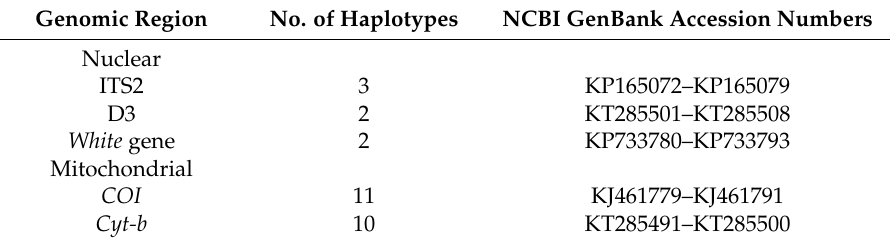
Table 7. Number of haplotypes of each genomic region and the accession numbers received from the NCBI